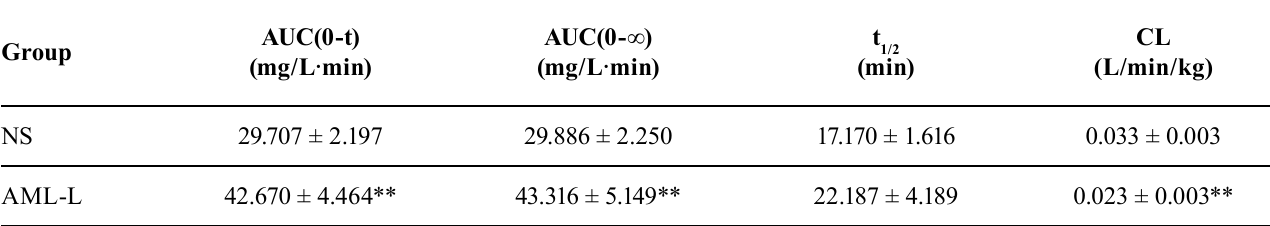
TABLE IV – Main pharmacokinetic parameters of phenacetin in rats (n=6, mean ± SD)